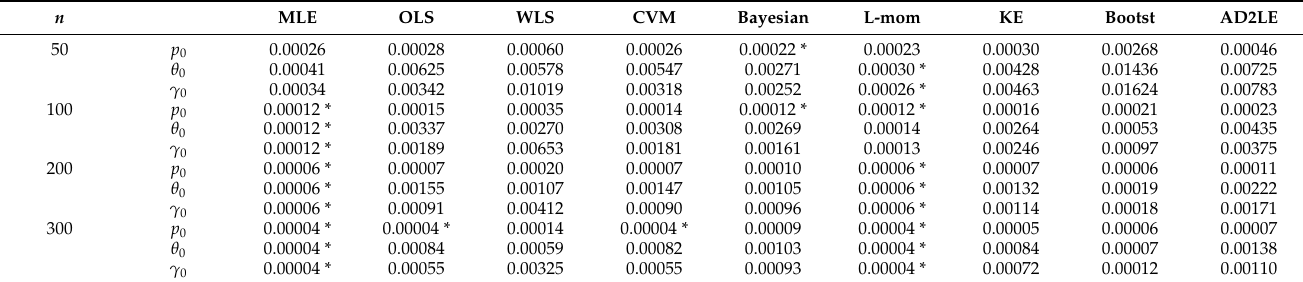
The value with “*” is the best estimation in its row for all estimation methods. Table 7. Results of the MSEs where p = 0.9, γ = 0.9, θ =